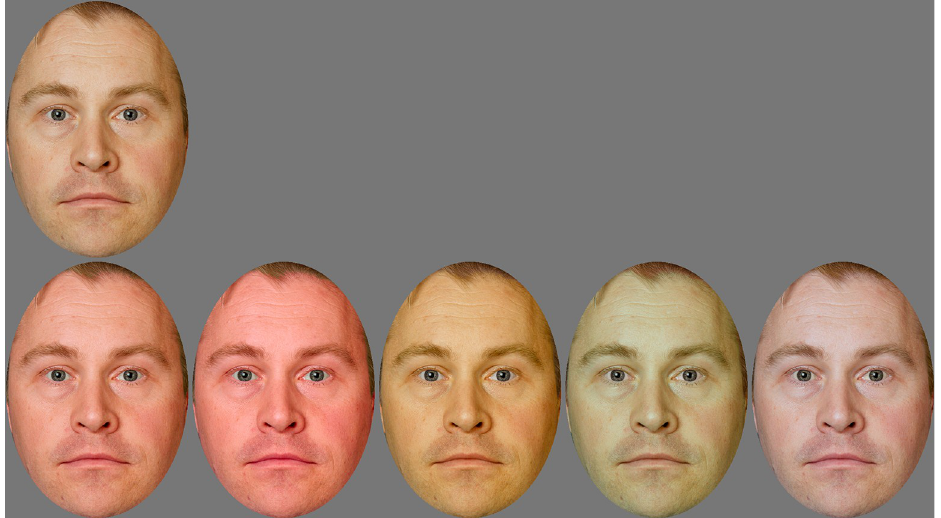
Fig 2. The facial color conditions. Top: baseline; bottom: red, red+, yellow, green, blue. Note that colors in this and following figures are only approximate on non-calibrated display